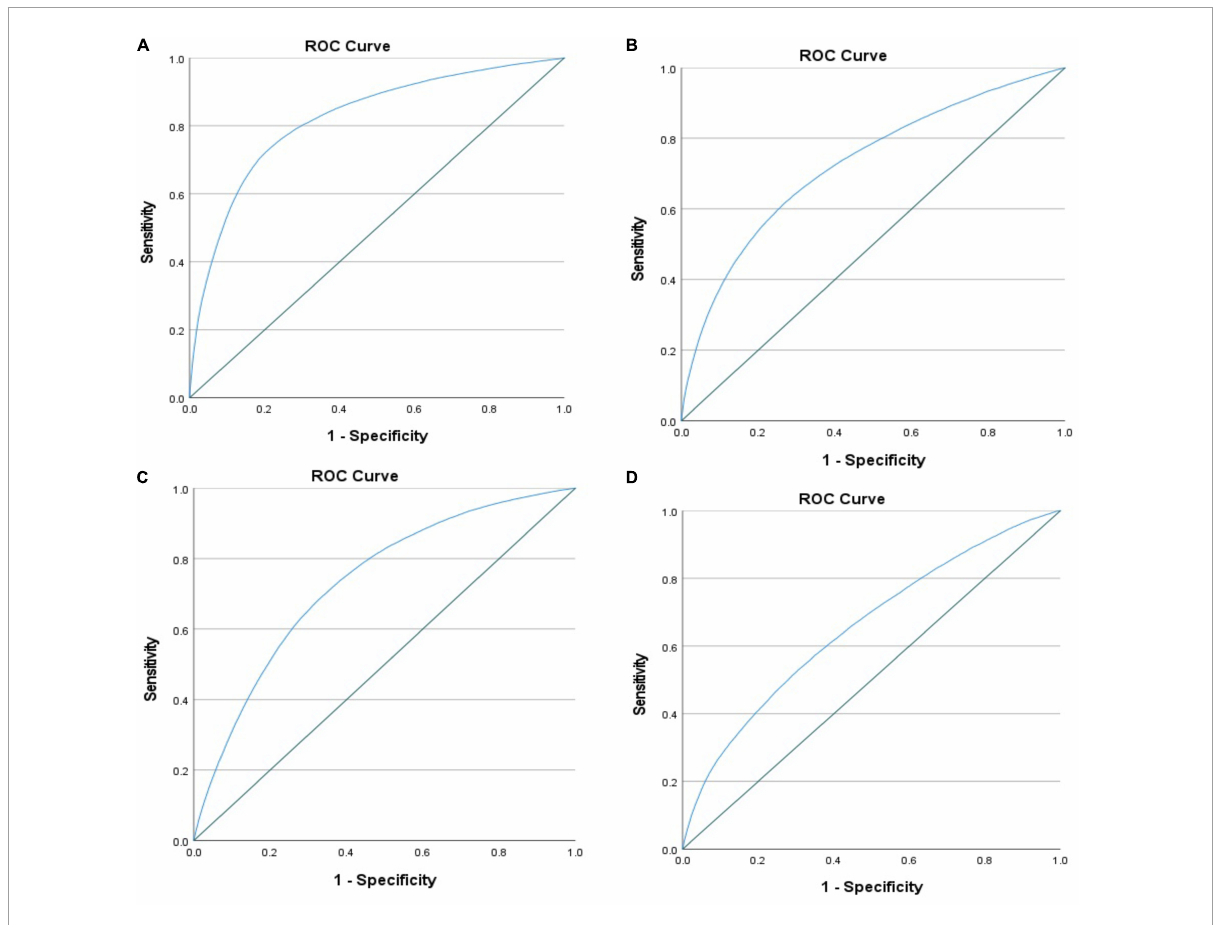
FIGURE4 ROC curve testing the prediction of the multivariable regression model in patients with STEMI and diabetes regarding (A) acute renal failure, (B) cardiogenic shock, mortality, (C) atrial fibrillation, and (D) ventricular